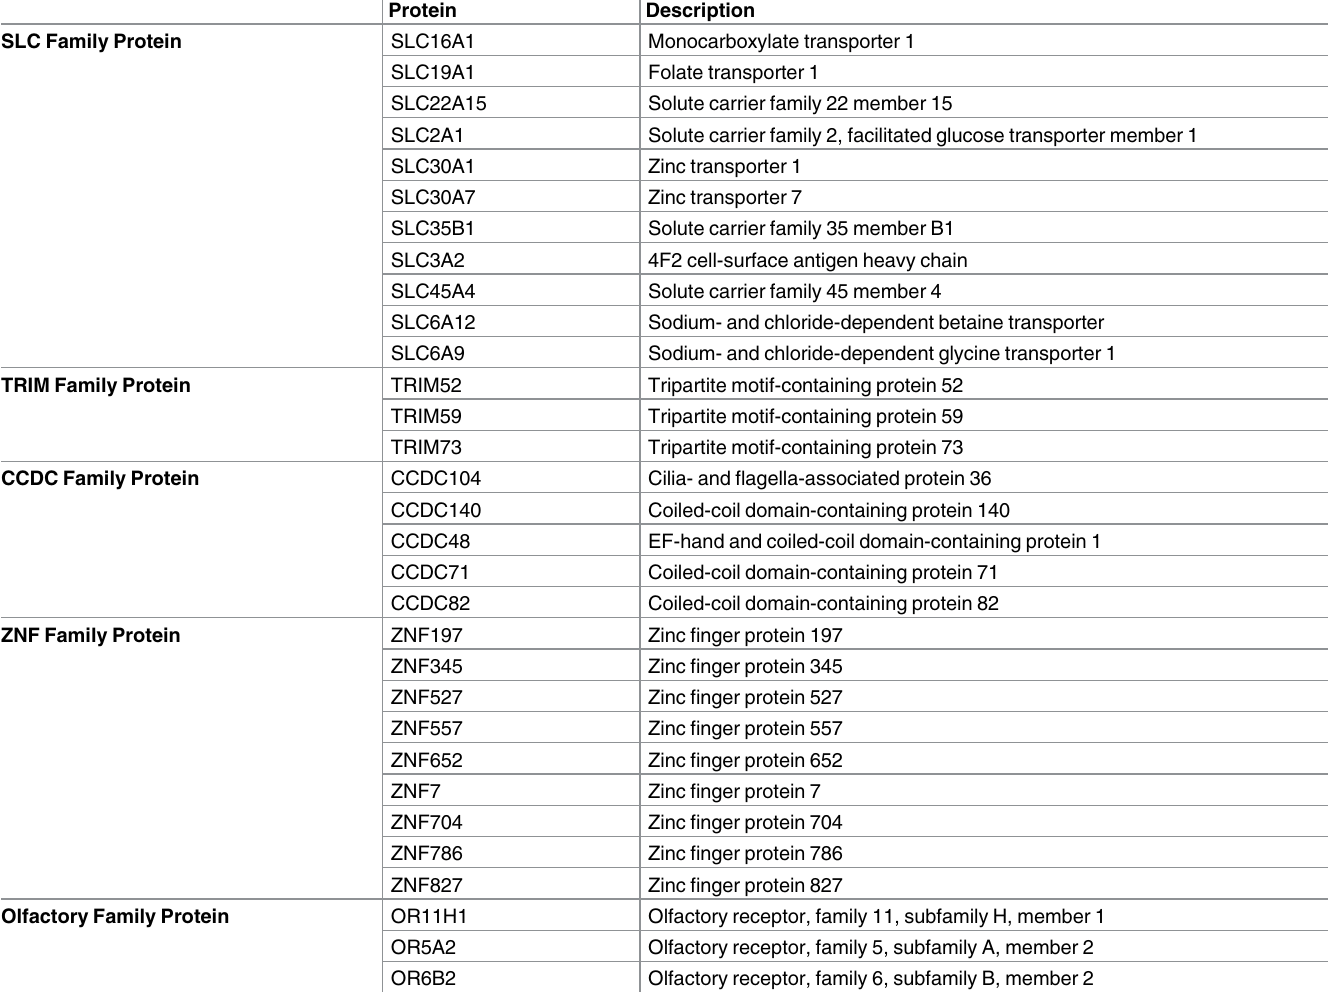
Table 8. Structurally related grouping of brain vascularmarkers identified from the Human Protein Atlas. Clusters of structurally related proteins were identified in brain vessels and are listed in groupsthat includethe SLC, TRIM, CCDC, ZNF, and OR protein